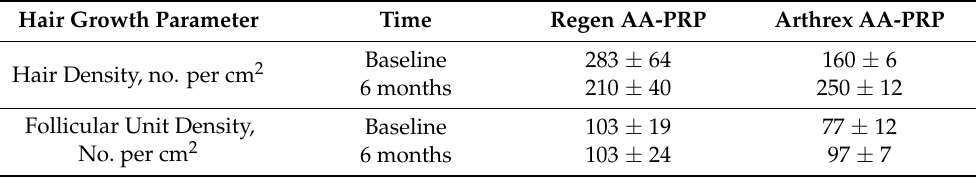
Table 2. Hair-growth parameters assessed by photography for the AA-PRP treatment groups at baseline and after six months.